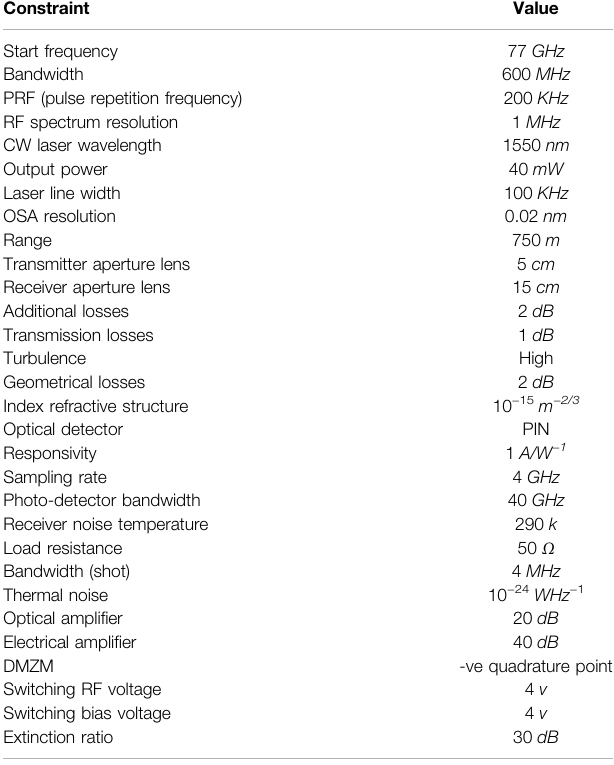
TABLE 1 | System parameter.